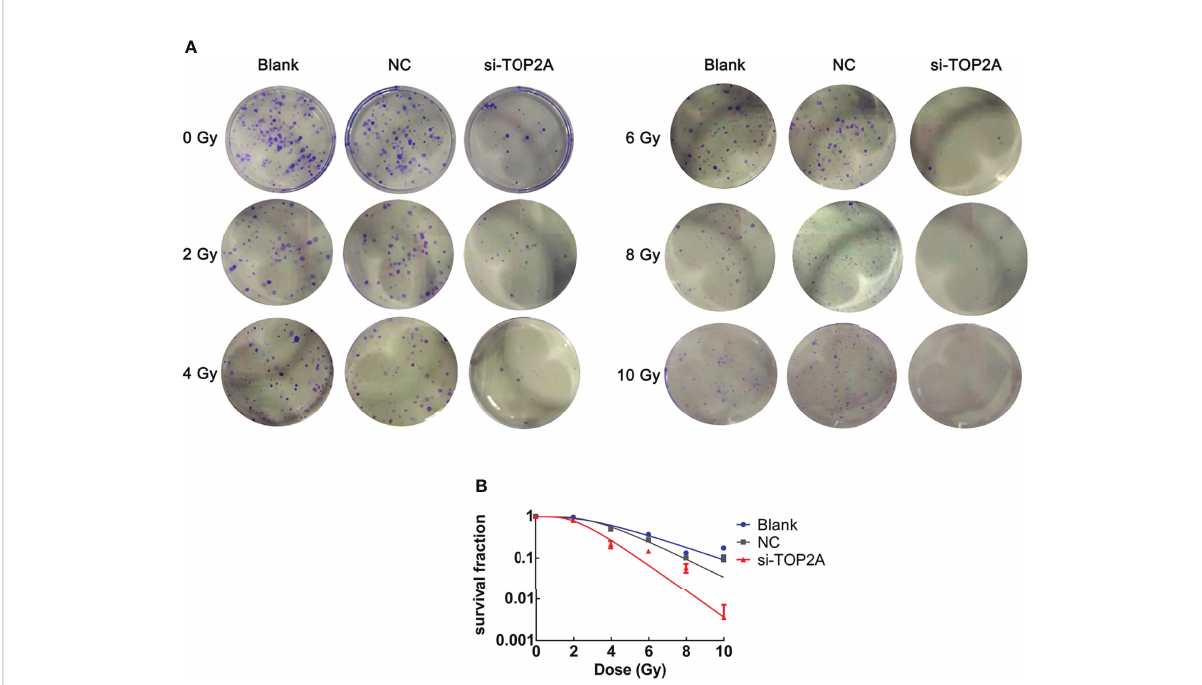
FIGURE 7 Downregulation of TOP2A limits the radioresistance of MB cells. (A) Colony formation assays were employed to evaluate the radiosensitivity of MB cells individually exposed to 0, 2, 4, 6, 8, and 10 Gy IR, respectively. (B) Cell survival curves analysis were performed to assess the radioresistance of MB cells.